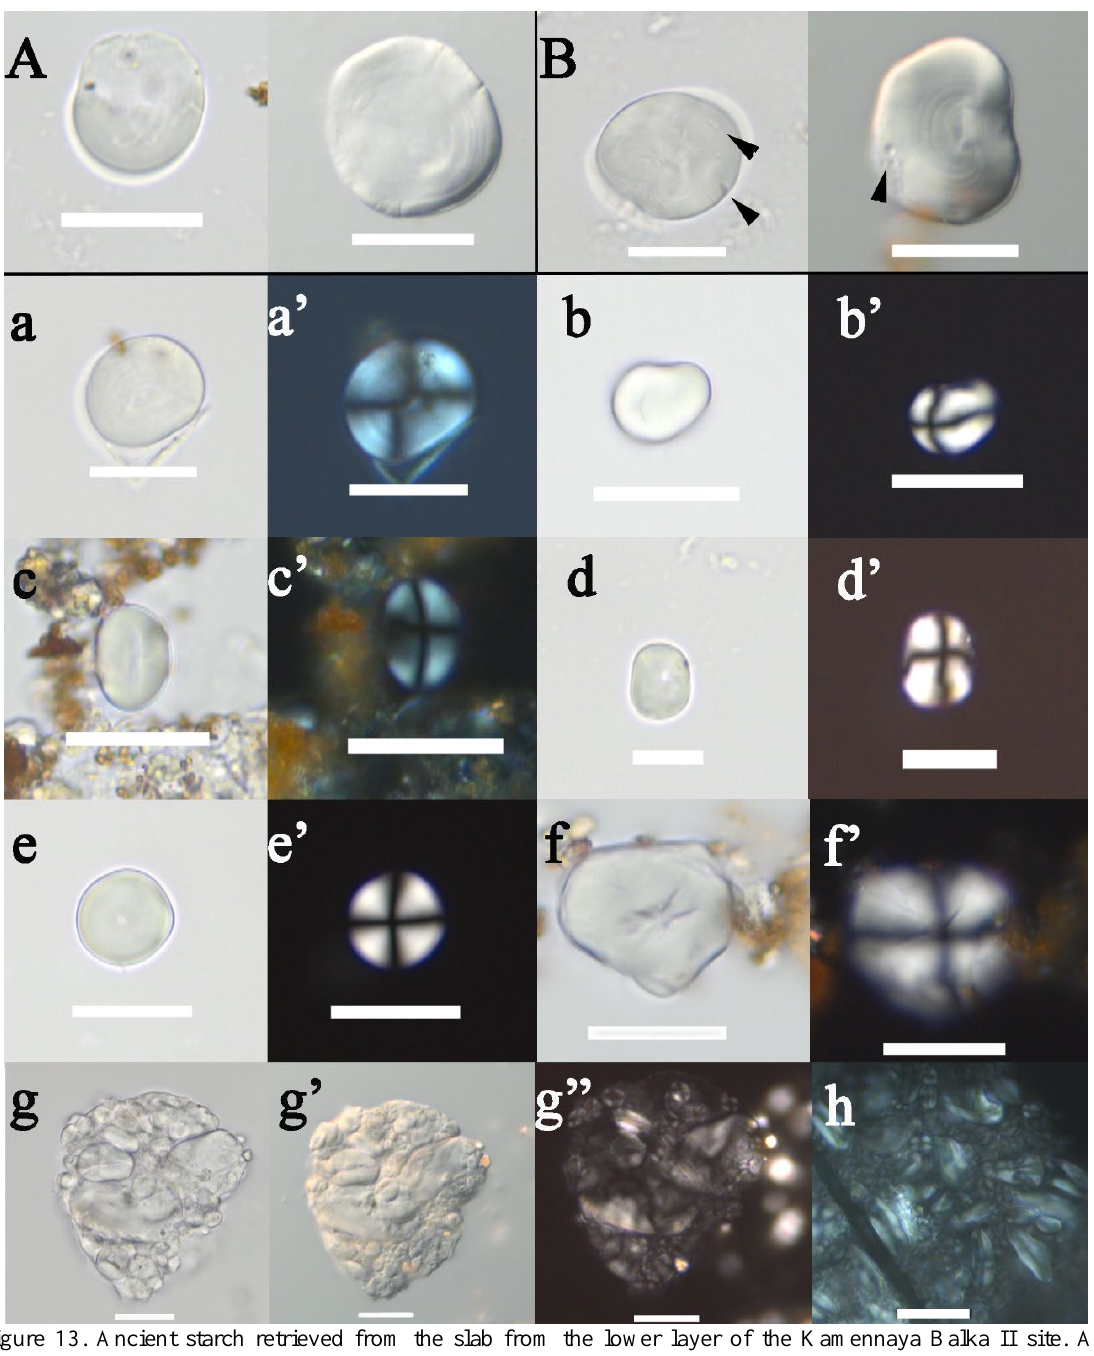
Figure 13. Ancient starch retrieved from the slab from the lower layer of the Kamennaya Balka II site. A - mechanically damaged starch granules. B - traces of enzymatic action on the shell. Arrows point to craters. A & B - granules of type 1. a - type 1; b - type 2; c - type 3; d - type 4; e - type 5; f - type 6; g - starch clamp, type 1; h - a clamp of modern starch (Elymus sp.), type 1. A on left, B on left, a, b, c, d, e, f, g - bright field; a', b', c', d', e', f ', g'', h - polarization mode; A on right, B on right, g' - DIC contrast mode. Scale bar: 20 μm, d - 10